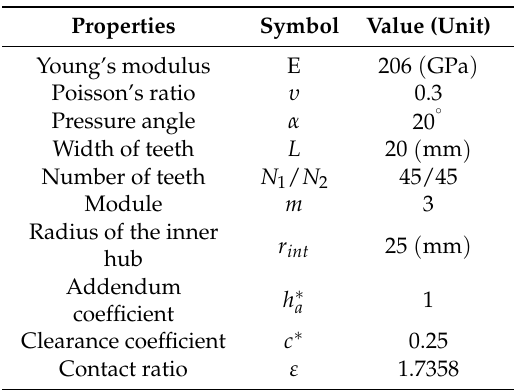
Table 2. The parameters of the example gear